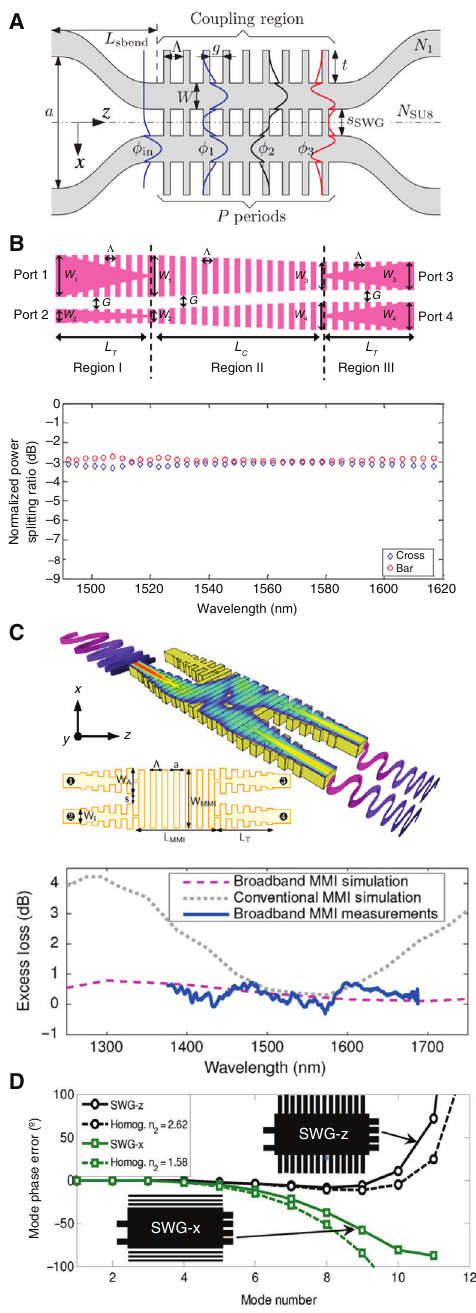
Figure 14: Results for various subwavelength structured couplers and